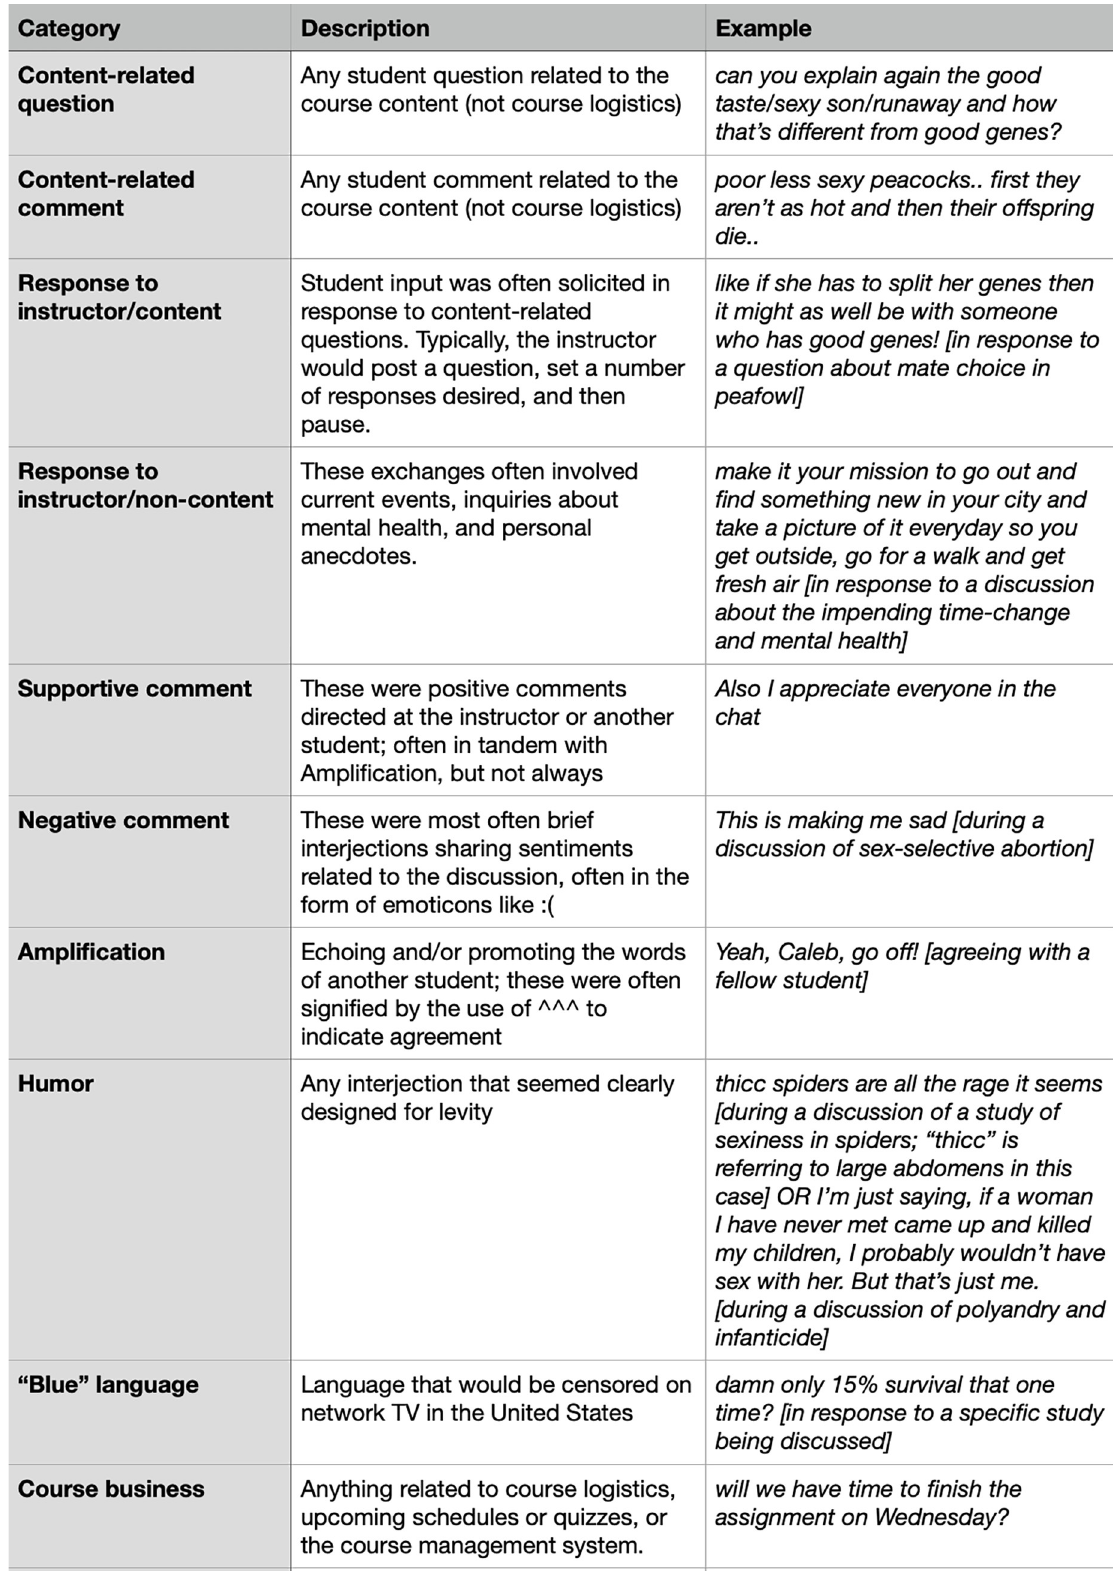
Fig 1. Categories assigned to coded comments, along with an example for each category. https://doi.org/10.1371/journal.pone.0273301.g001 PLOS ONE | https://doi.org/10.1371/journal.pone.0273301 October 19,